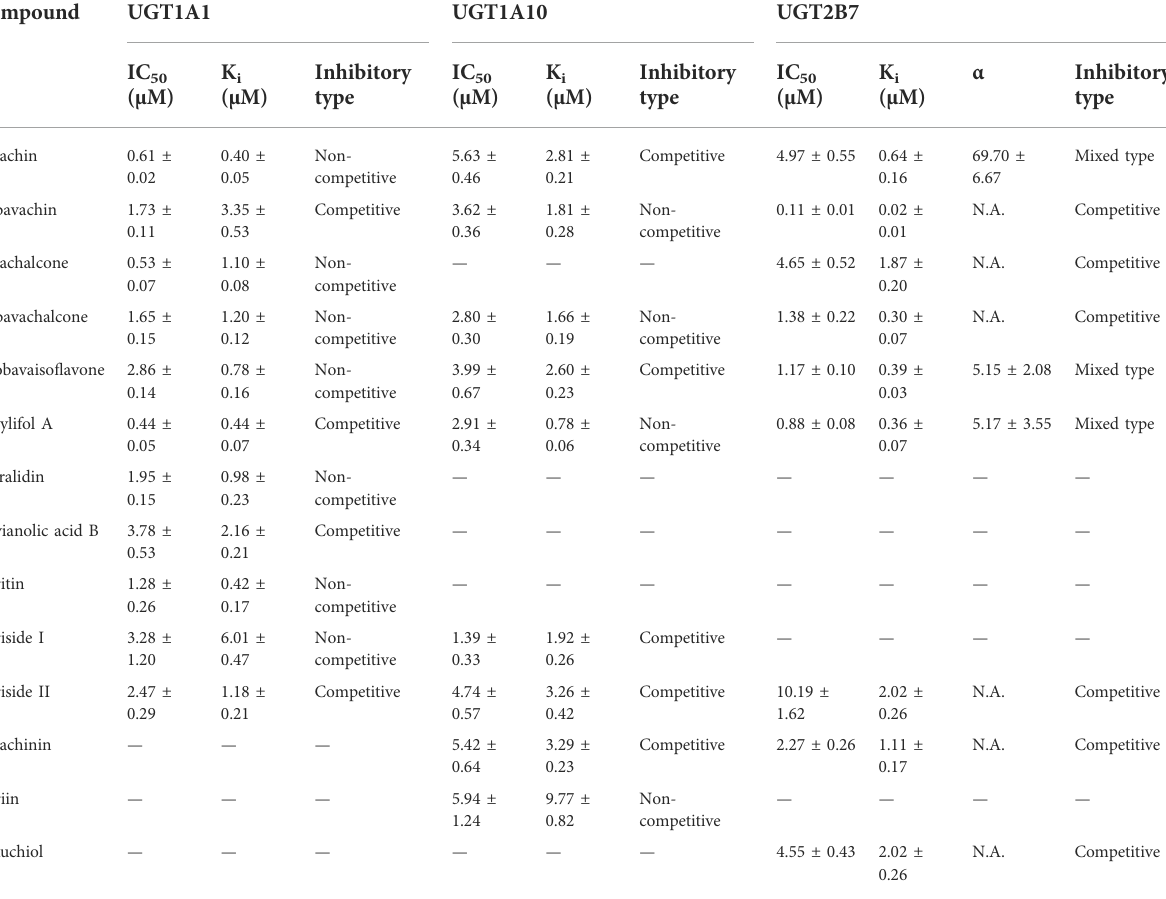
TABLE 2 Inhibitory parameters of natural compounds derived from XLGB against UGT1A1, UGT1A10, and UGT2B7 (Mean ± SD). All experiments were performed in triplicate.